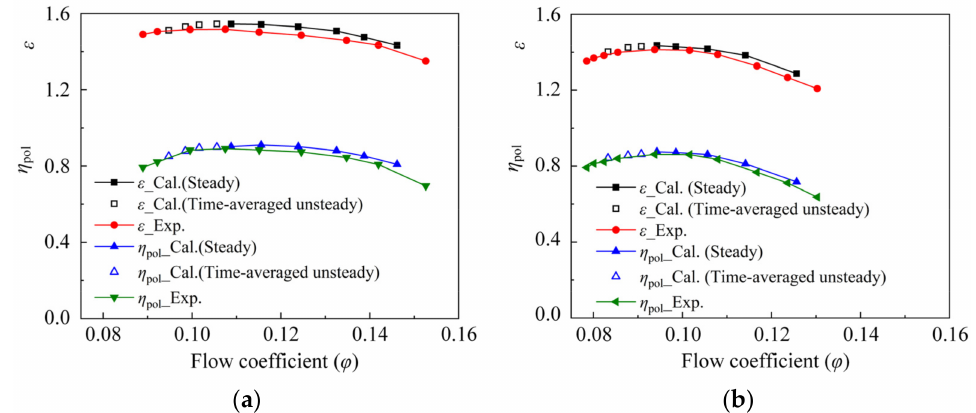
Figure 4. Comparison of numerical results with experimental data for the stage: ( a ) IGV0; ( b ) IGV60. To further verify the accuracy of the numerical method, the spectrum analysis of the static pressure fluctuation at the inlet of the diffuser is shown in Figure 5. This figure compares the transient results and measurement data of IGV45 at low mass flow rate condition ( ϕ = 0.0833). As is shown in the figure, although the predicted amplitude is higher than the experimental data, the expected low frequency, blade passing frequency (BPF), and double blade passing frequency (2BPF) are in good agreement with the experimentally measured value.